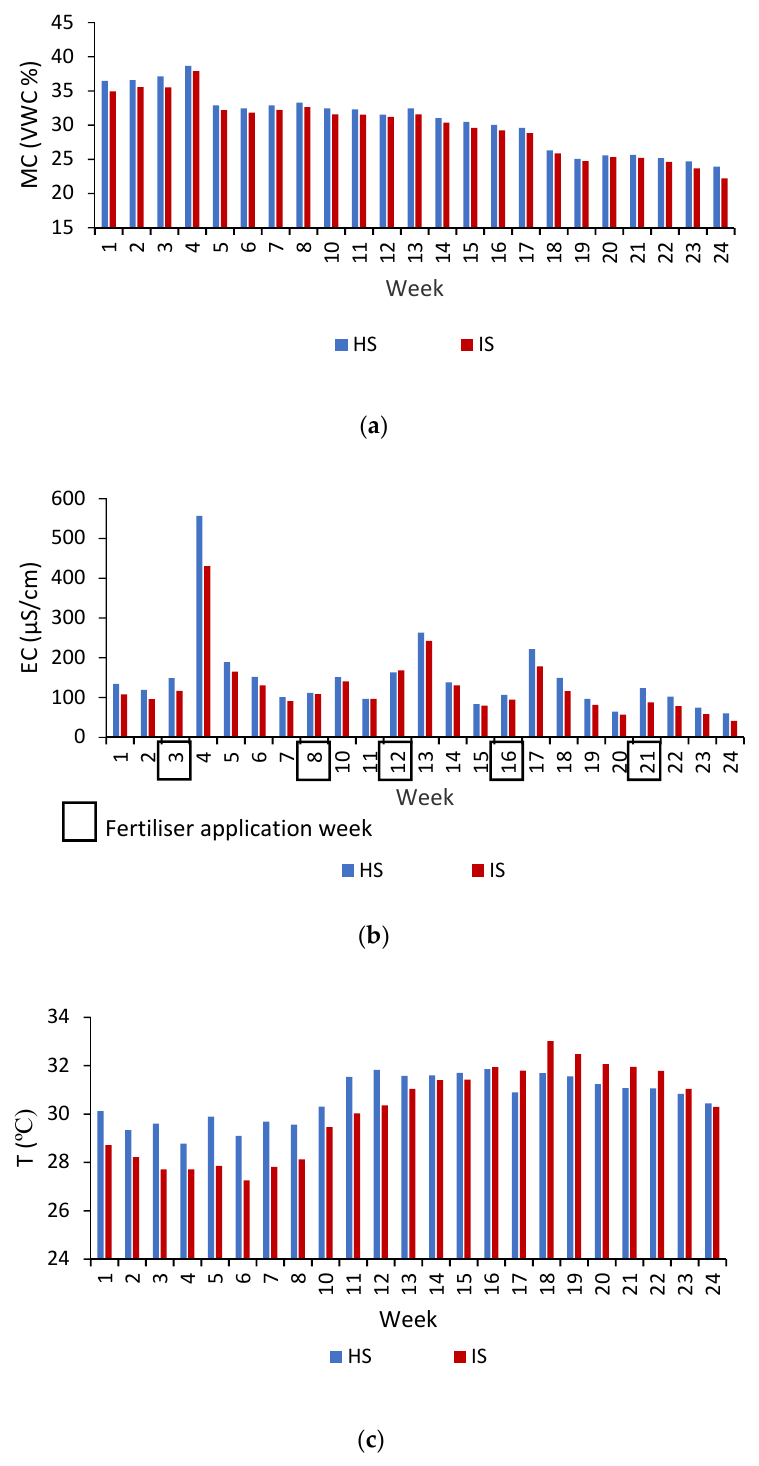
Figure 7. Mean of soil ( a ) moisture content (MC), ( b ) electrical conductivity (EC) and ( c ) tempera- ture (T) of healthy seedlings (HS) and infected seedlings (IS) over 24